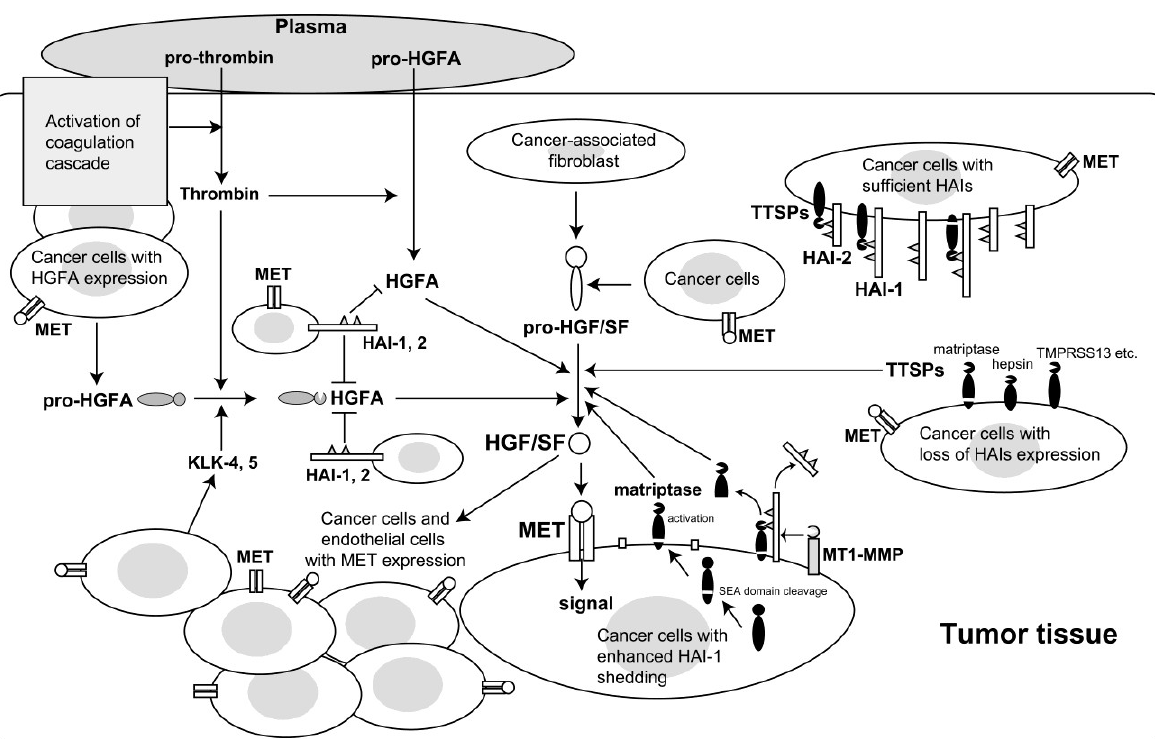
Figure 1. Hypothetical model of HGF/SF activation in cancer. There are two major pathways in the activation of HGF/SF in tumor tissue. One is HGFA-mediated pathway that is closely linked to activation of the coagulation cascade. Another pathway is TTSPs-mediated one, in which matriptase likely has a signiificant role. Cellular Kunitz-type serine protease inhibitors, HAI-1 and HAI-2, have crucial roles in the regulation of these HGF/SF-activating proteases in tumor